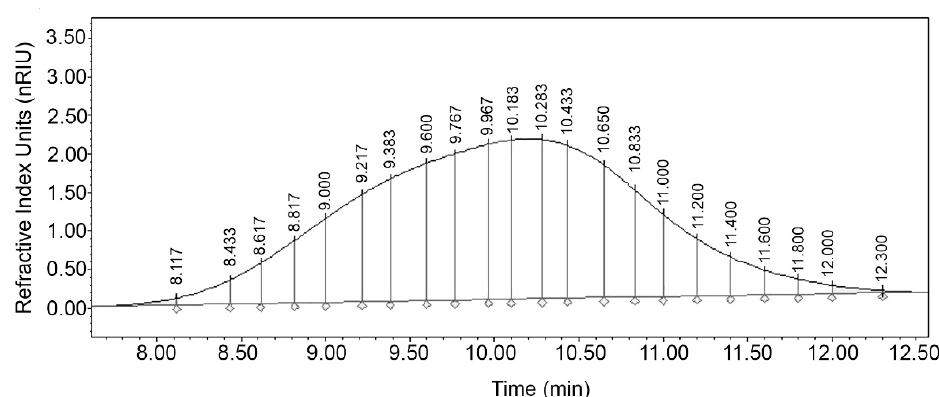
Figure 1. Analytical curve of molecular weight of HA.